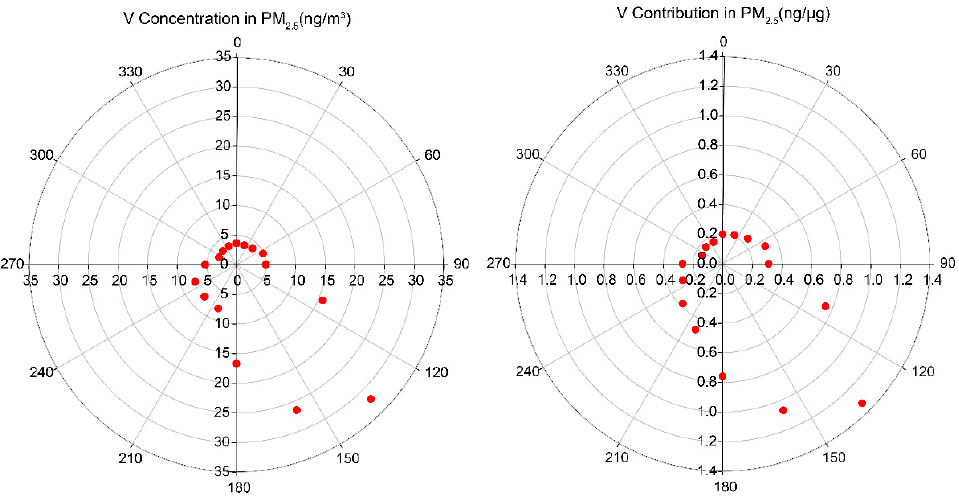
Figure 4. Vanadium (V) concentration in PM2.5 (ng/m 3 , left ) and the proportion of V in PM2.5 (ng/ µ g, right ) by wind direction (see Table S3 for more detail).